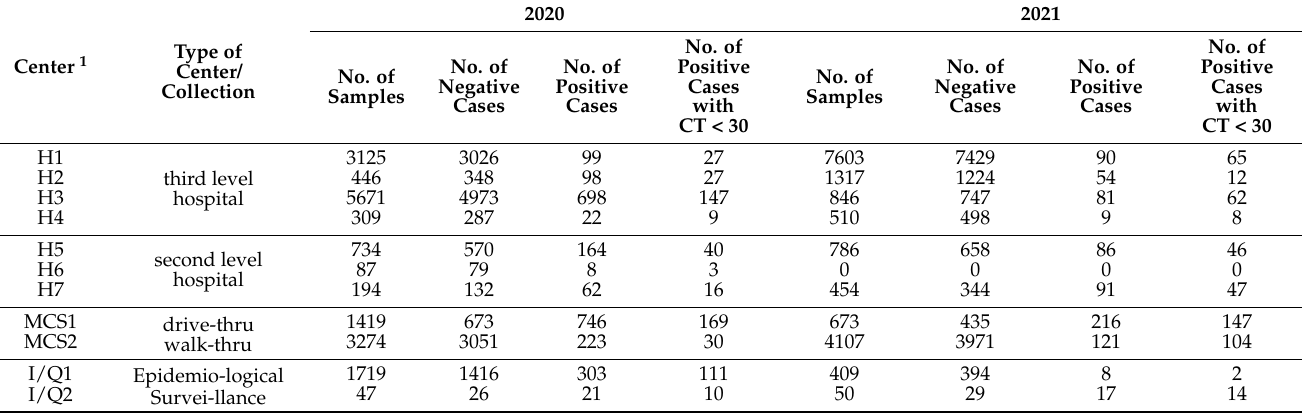
Table 1. Centers included in the study with the numbers of total samples and negative/positive cases recovered at each site in 2020 and